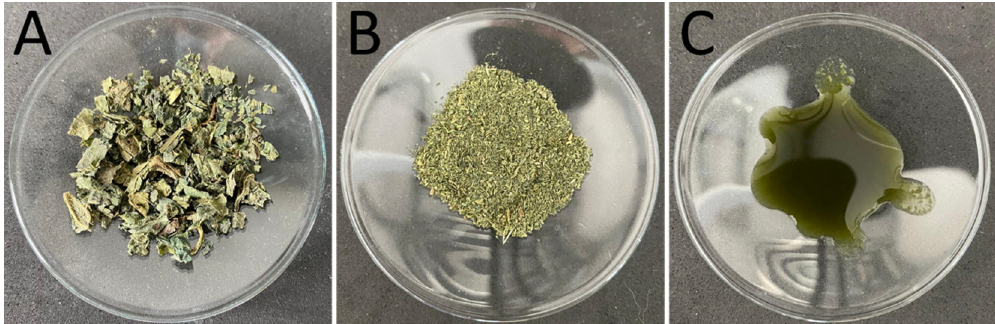
Figure 2. Macroscopic images of the samples. ( A ): Coarse stinging nettle leaves (bulk). ( B ): Dry milled powder (coffee mill (CM)). ( C ): PlantCrystals suspension (high-pressure homogenization (HPH)).